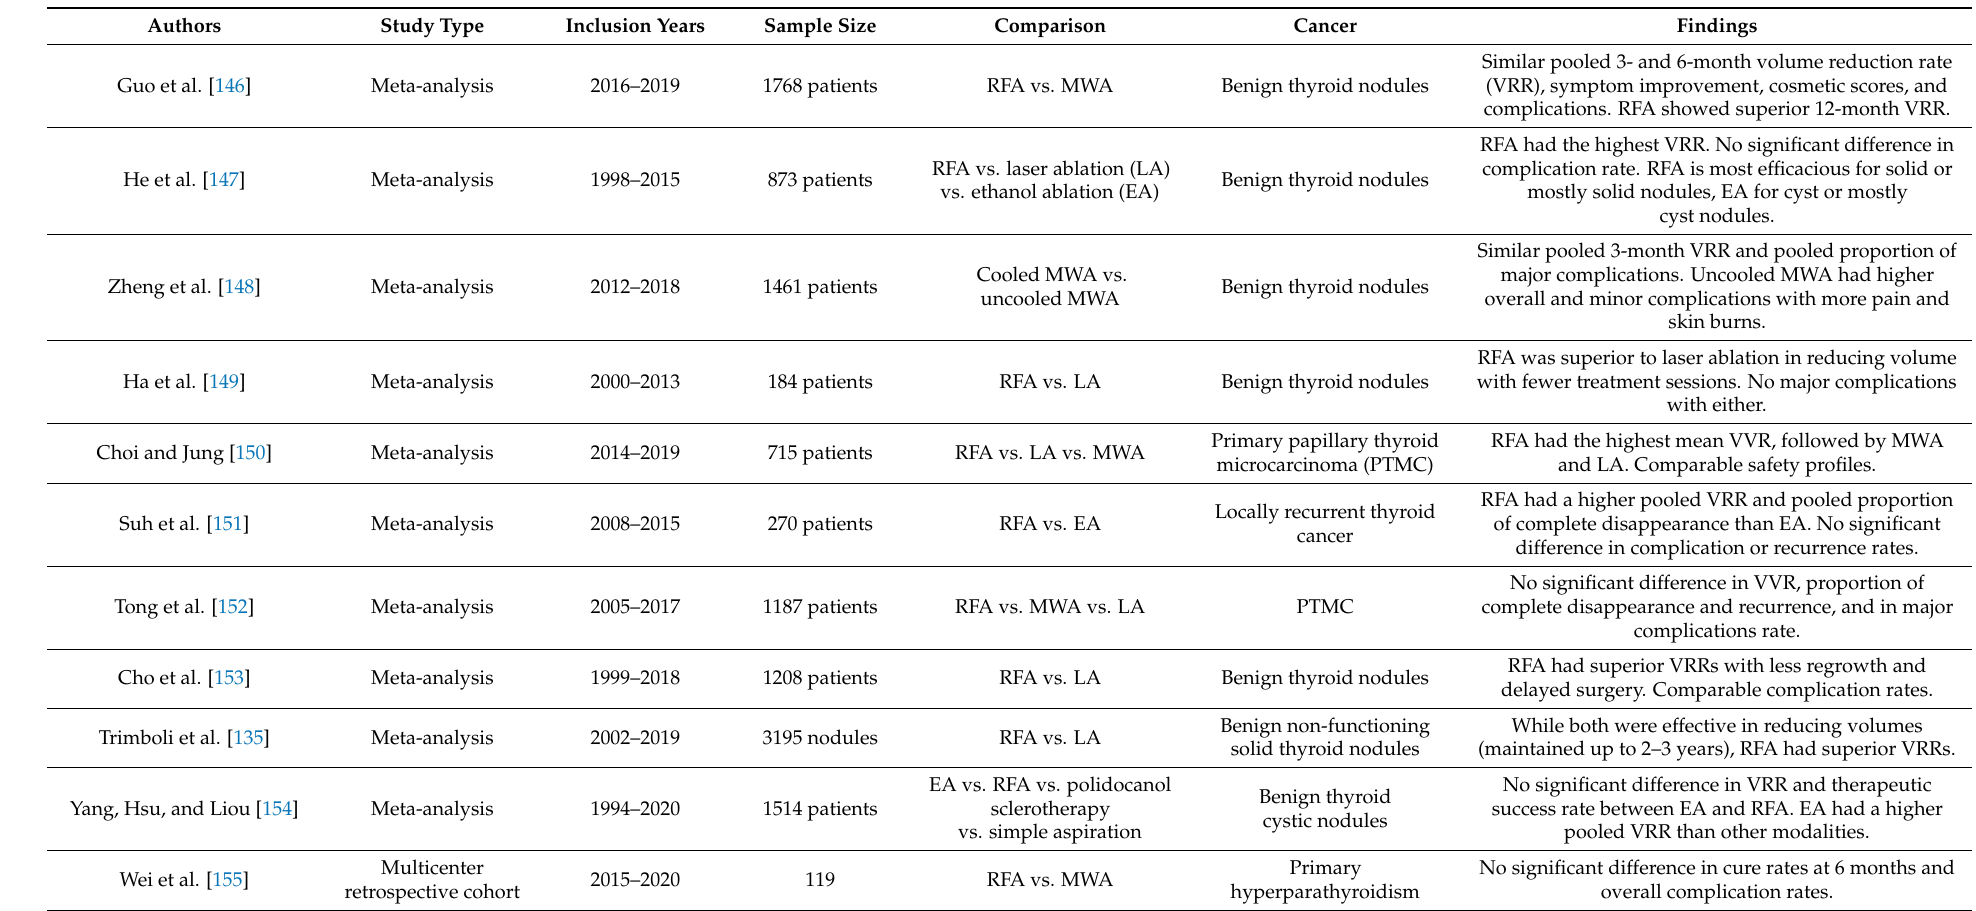
Table 4. Comparison of ablation modalities for thyroid and parathyroid